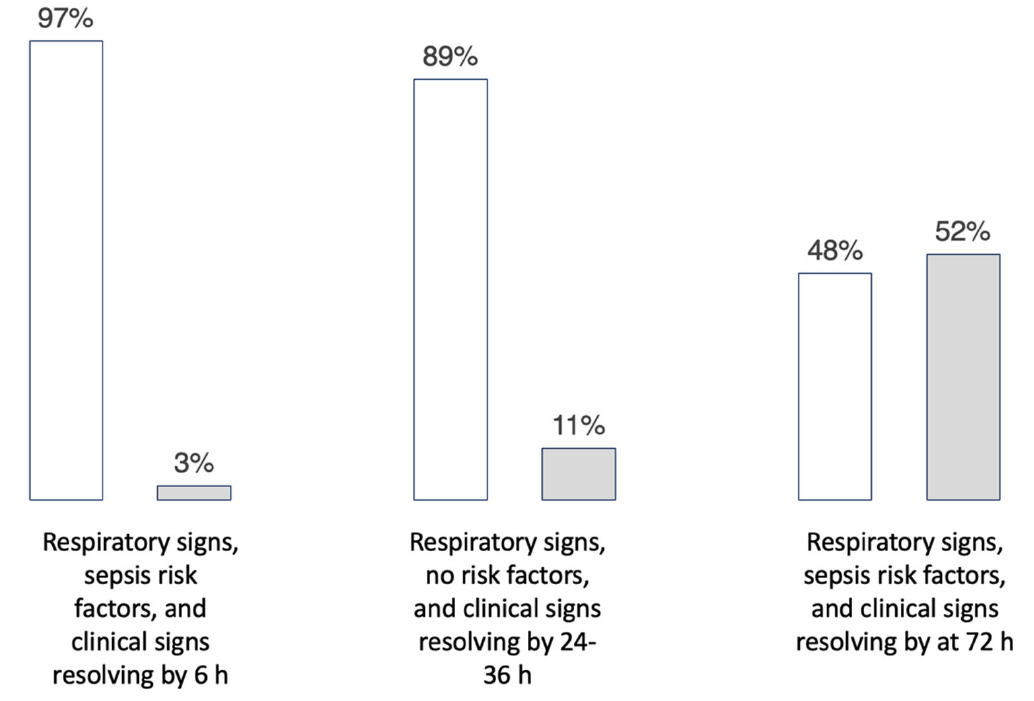
Figure 5. The set of histograms shows the results of a single vignette with three sets of variables added to determine the proportion of prescribers choosing to discontinue antibiotics (white) and the proportion choosing to continue antibiotics (grey).